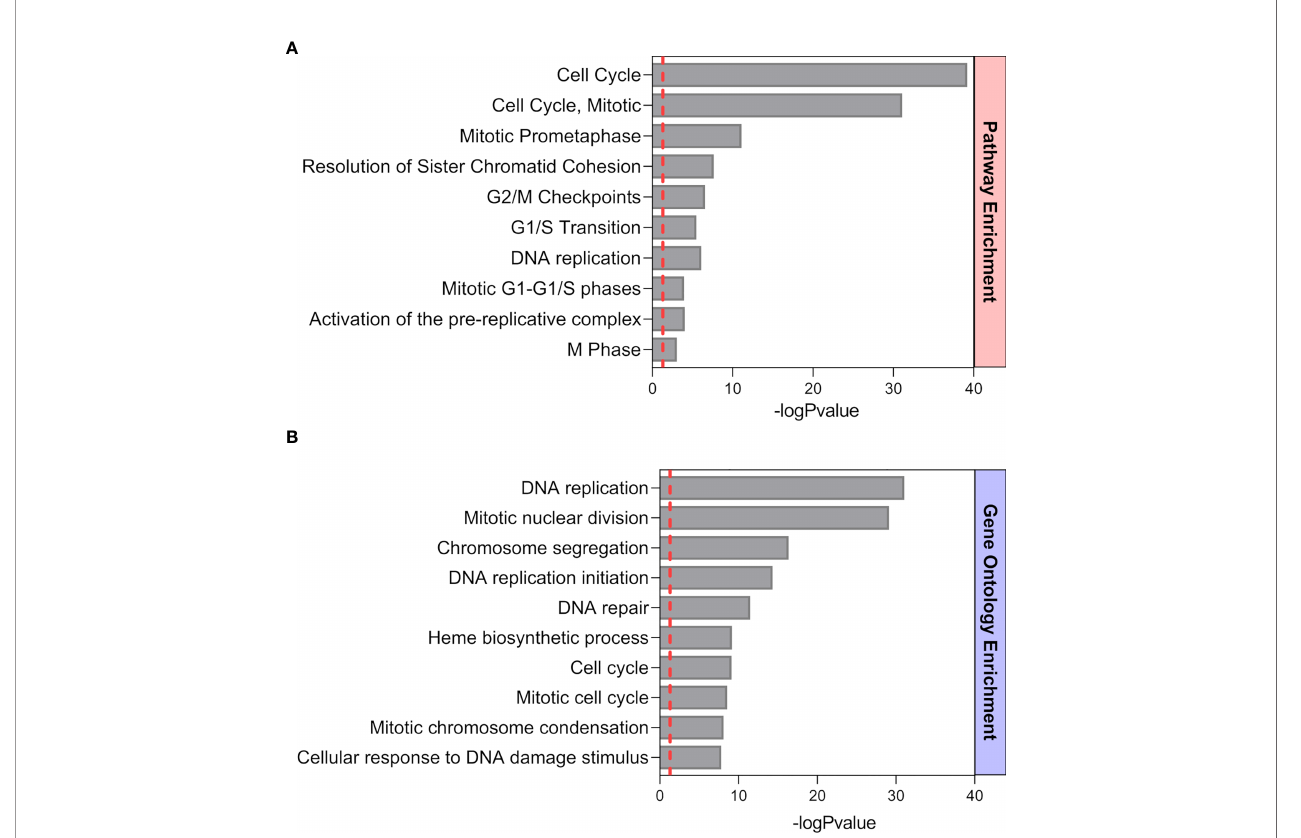
FIGURE 1 | Functional Pathway (A) and GO (B) enrichment analysis of up-regulated genes from a previously performed transcriptomic pro fi ling (24). Pathways and biological processes up-regulated in splenic B cells from P mice (n=4) compared to NP (n=4) animals. The ten most signi fi cant pathways and biological processes that showed a positive modulation are sorted by statistical signi fi cance using the -log 10 p-value (BH p< 0.05, fold changes >